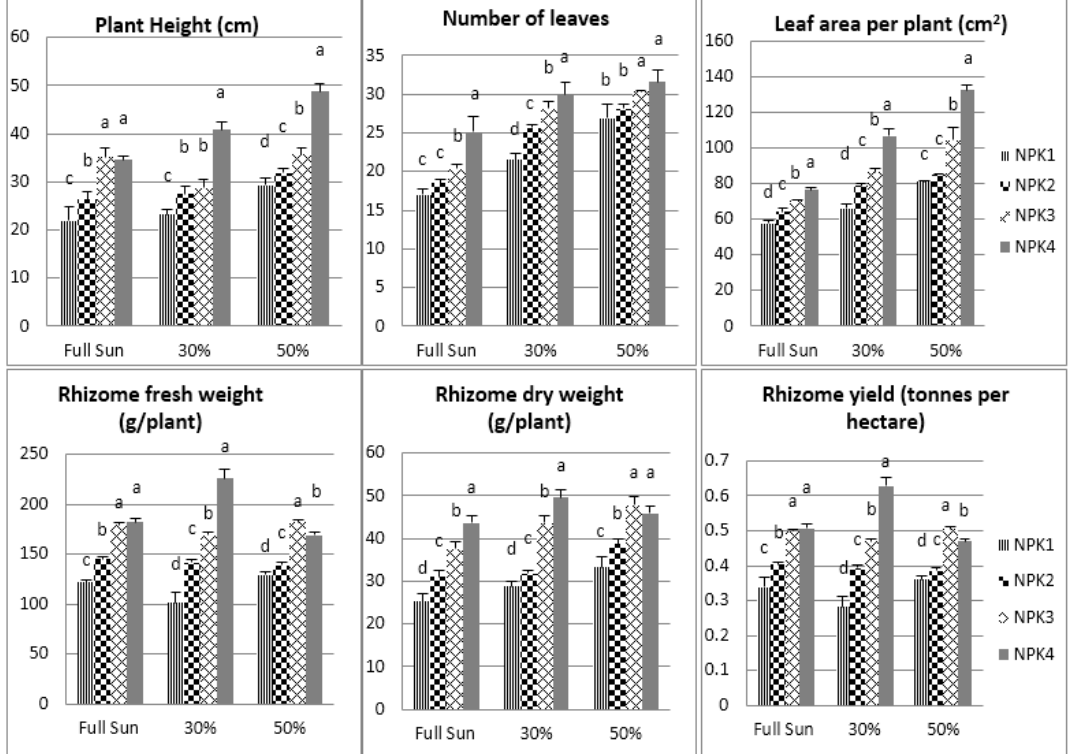
Figure 1. Effect of shade levels and NPK fertilizer rates on growth parameters, rhizome fresh weight, rhizome dry weight, and rhizome yield of Z. zerumbet . The means separations within each shade level were determined using DMRT at ( p < 0.05) level.